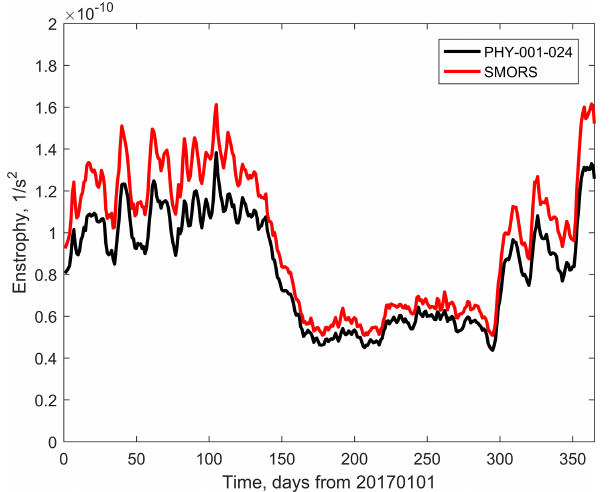
Figure 12. Seasonal variability of area-averaged enstrophy assessed from medium-resolution PHY_001_024 (black) and fine-resolution SMORS (red) models.